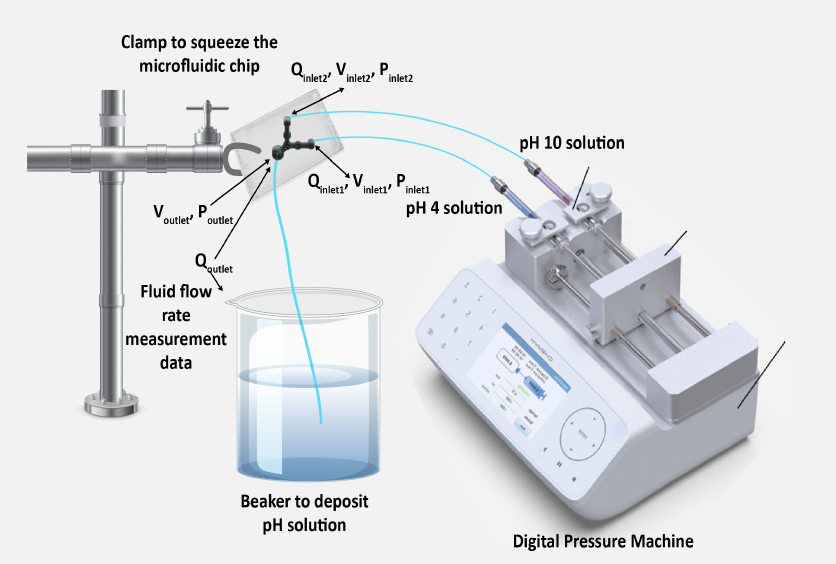
Figure 2. Using digital pressure machine, experimental measurement set up of a PDMS-made microfluidic chip to determine data of microfluidic